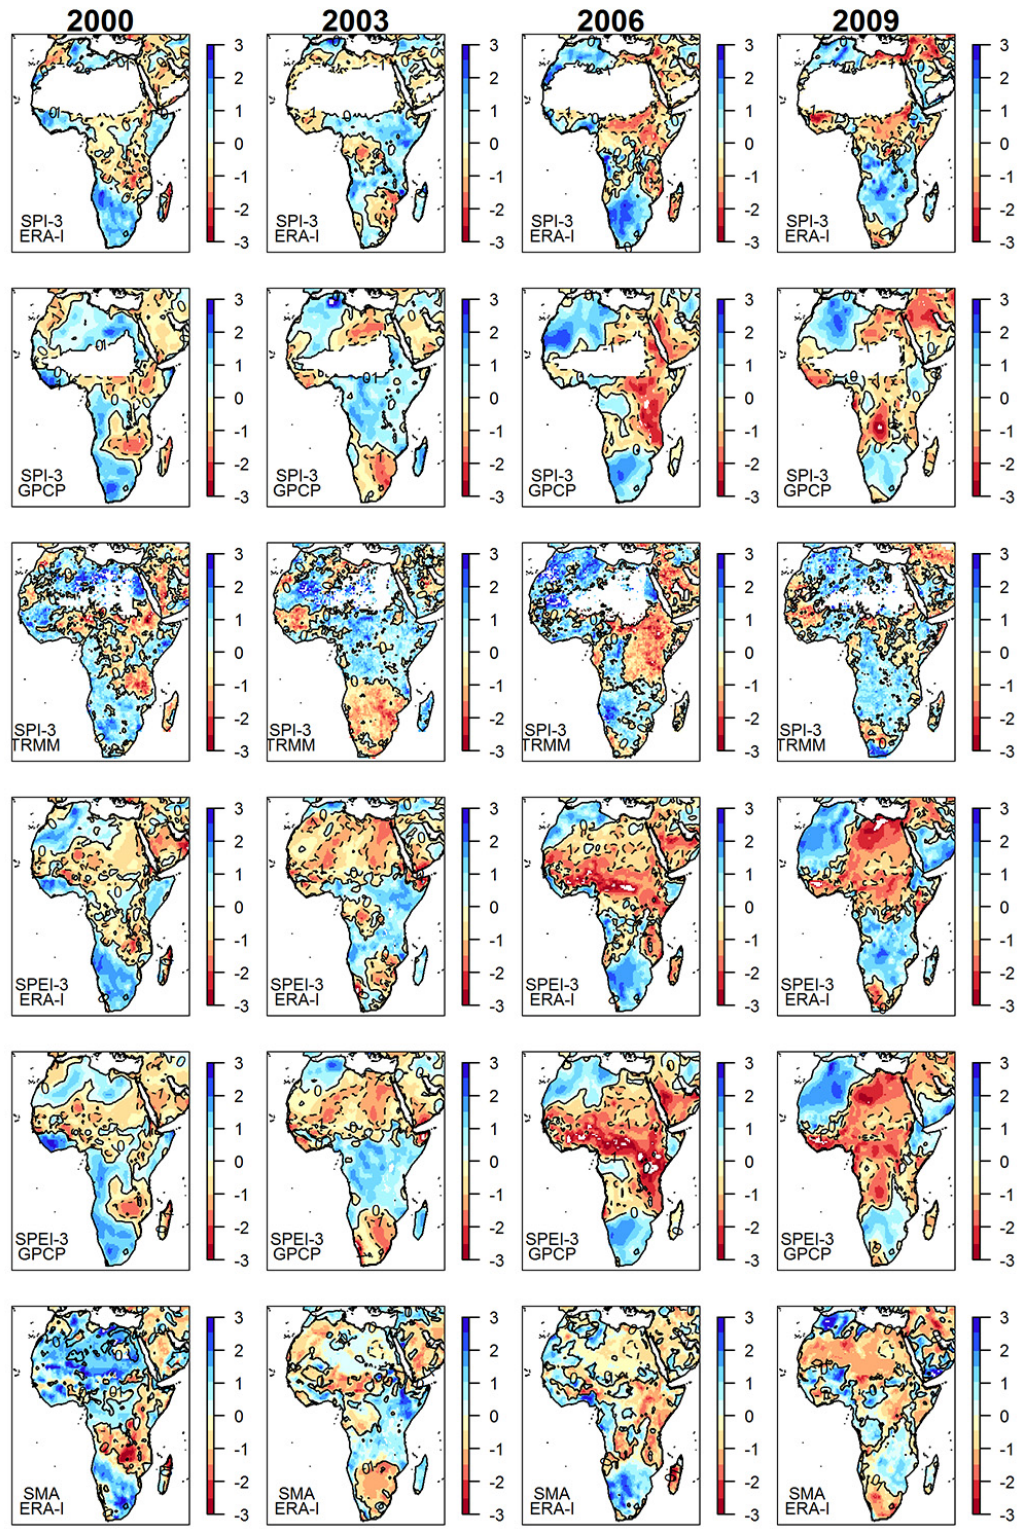
Fig. 4. Monthly standardized anomalies in SPI-3 (ERA-I, GPCP, TRMM), SPEI (ERA-I and GPCP) and Soil Moisture (SMA) for Jan- uary 2000, 2003, 2006 and 2009. Solid lines indicates the zero contour. White areas represent regions where it was not possible to compute the gamma parameters for SPI due to the large amount of